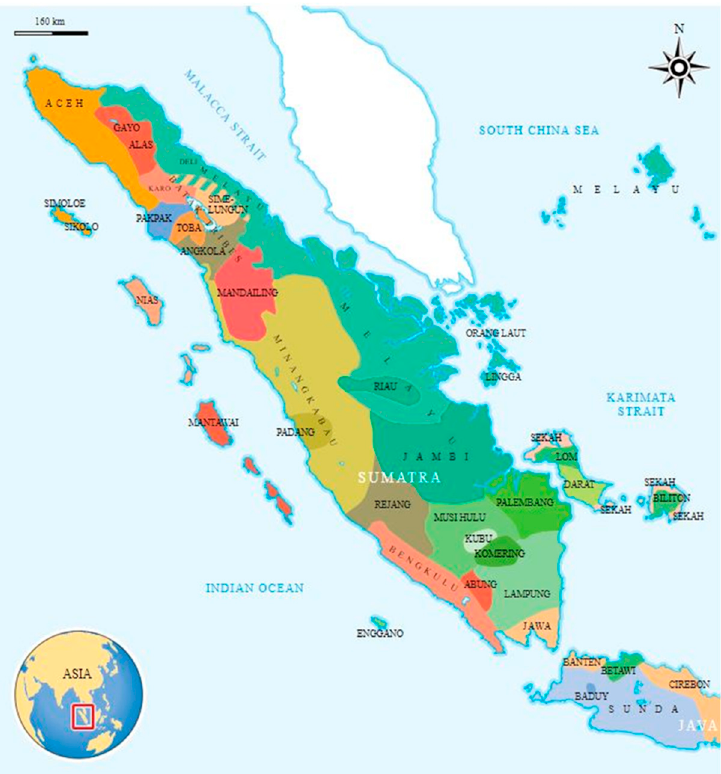
Figure 1. The map of ethnic groups in Sumatra islands and surroundings, Indonesia. The light and dark olive color on the center of the map shows the Minangkabau ethnic group, producing the authentic traditional fermented buffalo milk— dadih . Picture by: Gunawan Kartapranata, based on “Peta Suku Bangsa di Indonesia” at National Museum of Indonesia, Jakarta (CC BY-SA 3.0, source: https://upload.wikimedia.org/wikipedia/commons/archive/8/8c/20180810080403%21Sumatra_Ethnic_Groups_Map_en.svg) (accessed on 16 May 2021).